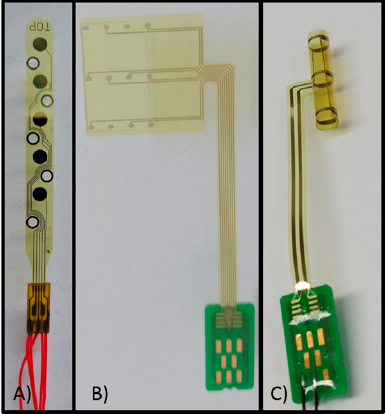
Figure 1. Three flexible Pt microelectrodes with circular contacts, designed and fabricated at Fraunhofer IBMT: ( A ) planar Pt electrode with 5 contacts, ( B ) cuff Pt electrode with 12 contacts, ( C ) cuff microporous Pt electrode with 12 contacts.